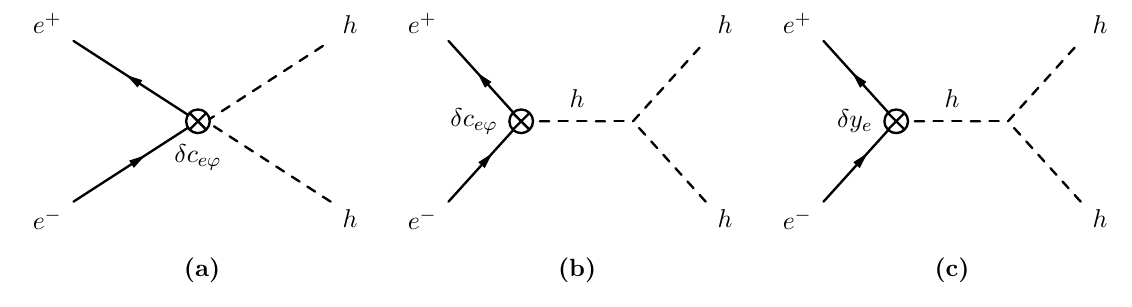
Figure 8. Counterterm diagrams for e + e (cid:0) ! hh